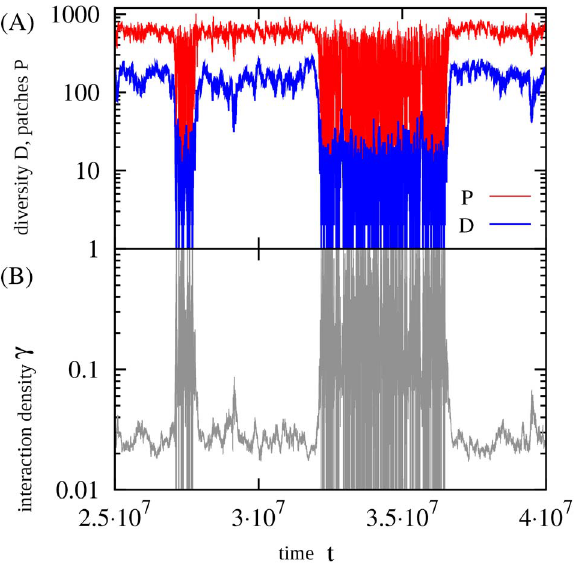
Figure 2. Time evolution in the steady state. (A) Diversity (number of species), D , and number of patches, P , and (B) interaction density c .